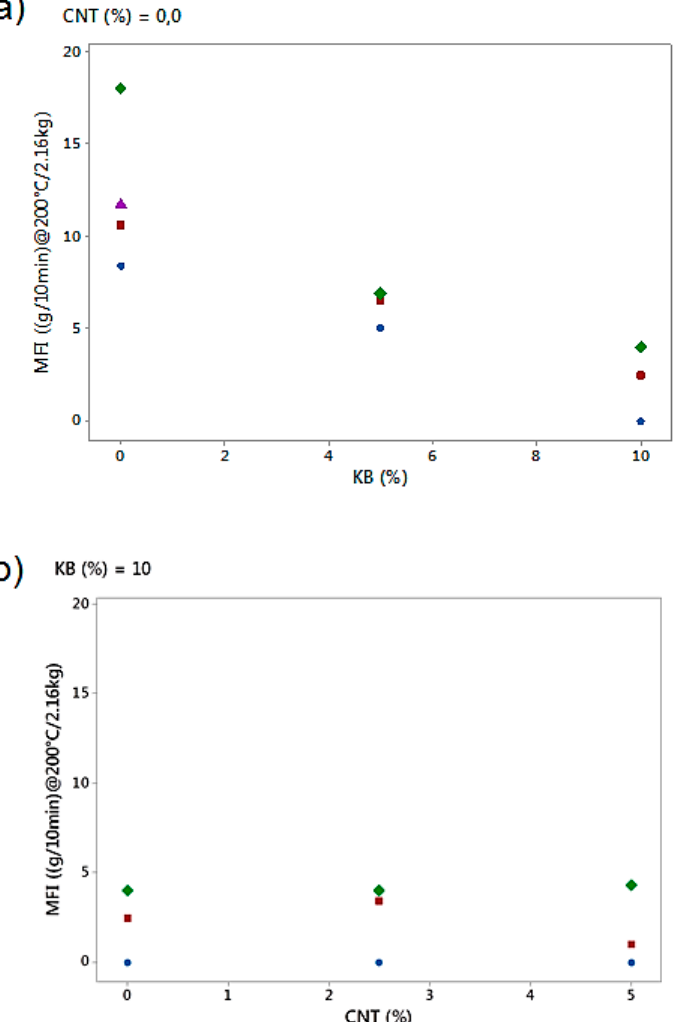
Figure 10. Effect of percentages of KB ( a ) and CNT ( b ) on the MFI (g/min at 200 °C/2.16 kg) of the conducting biphasic blends depending on the percentage of PBE. The blends containing 0%, 40%, 60% and 100% of PBE are represented in blue, red, green and purple.